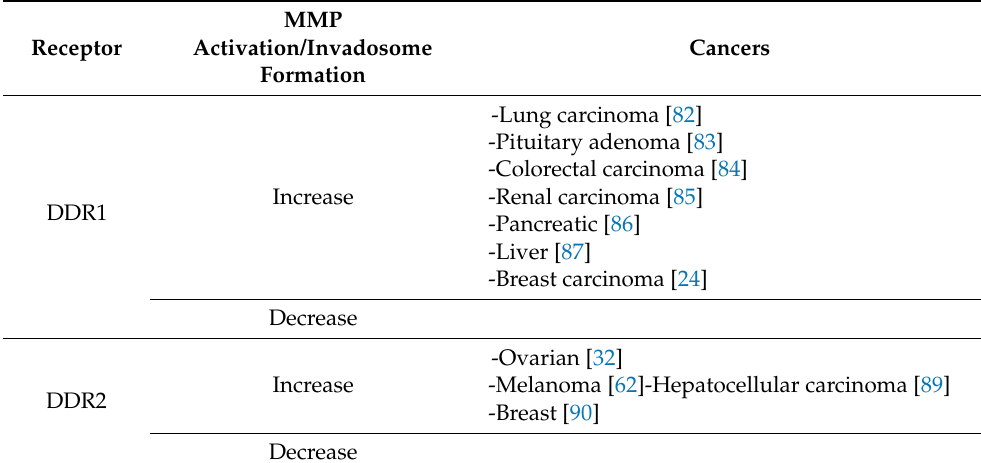
Table 2. Roles of DDRs in matrix metalloproteinase (MMP) activation and invadosome